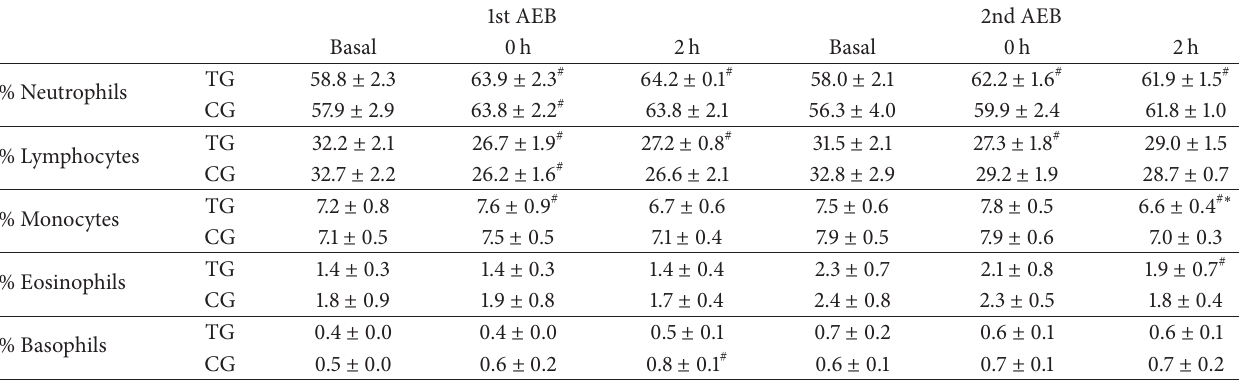
Table 1: Distribution of PBMC before (basal) and immediately after (0 h) and 2 hours after (2h) the acute eccentric bout (AEB) performed before (1st AEB) and after (2nd AEB) the intervention for training group (TG) and control group (CG). 1st